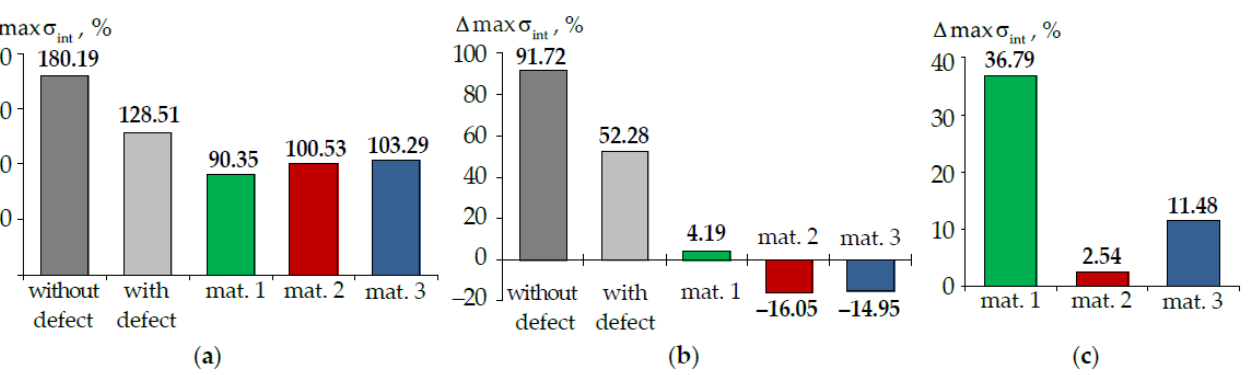
Figure 13. ∆ max σ int : ( a ) is enamel; ( b ) is dentine; ( c ) is inlay; dark-grey is model without defect; light-grey is model with defect; green is model with material 1 inlay, red is model with material 2 inlay, blue is model with material 3 inlay.